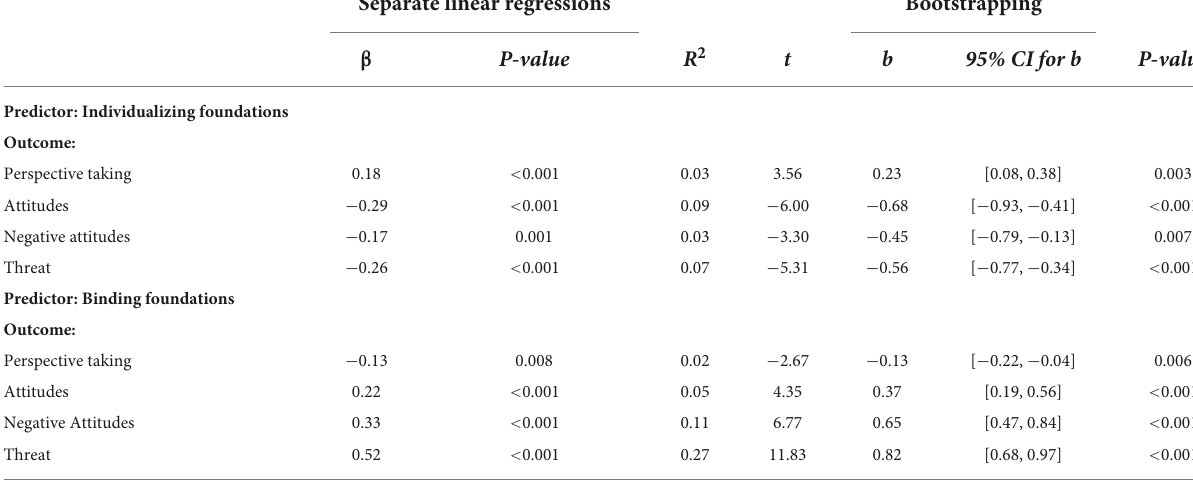
TABLE 2 Linear regression analyses of moral foundation indexes to outcomes for Study 2. Separate linear regressions